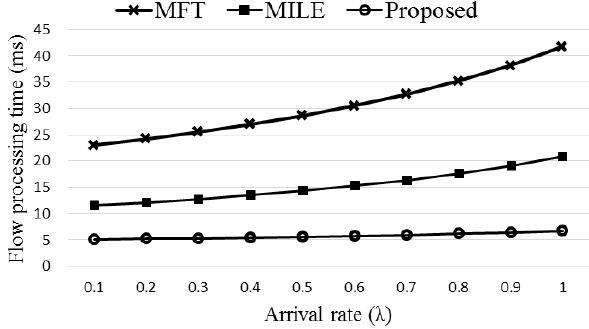
Figure 13. The comparison of flow processing times with varied arrival rate.